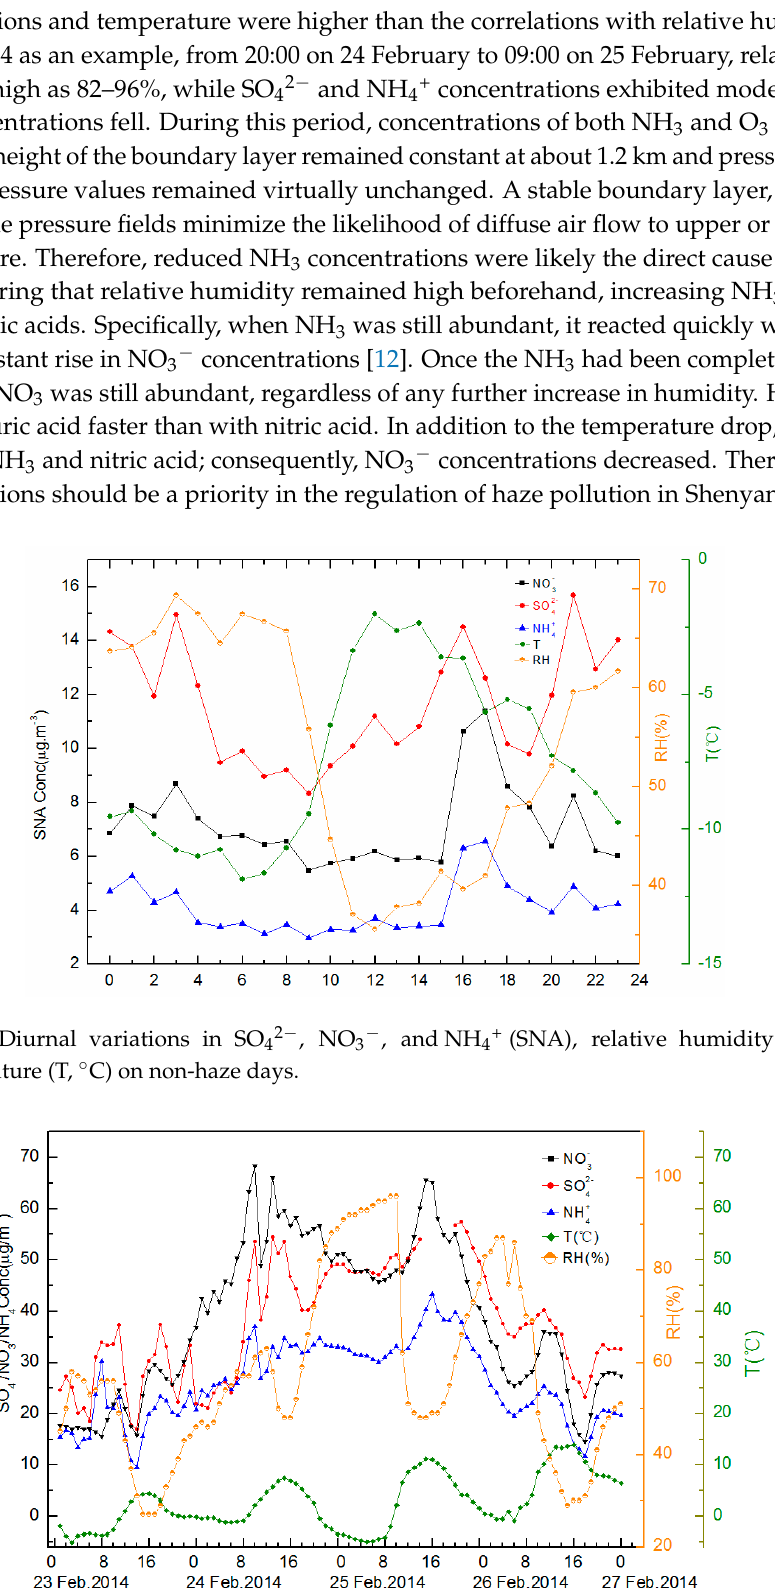
Figure 8. Diurnal variations in SO 42 − , NO 3 − , and NH 4+ ( SNA), relative humidity (RH, %), and temperature (T, °C) on days influenced by complex pollution.